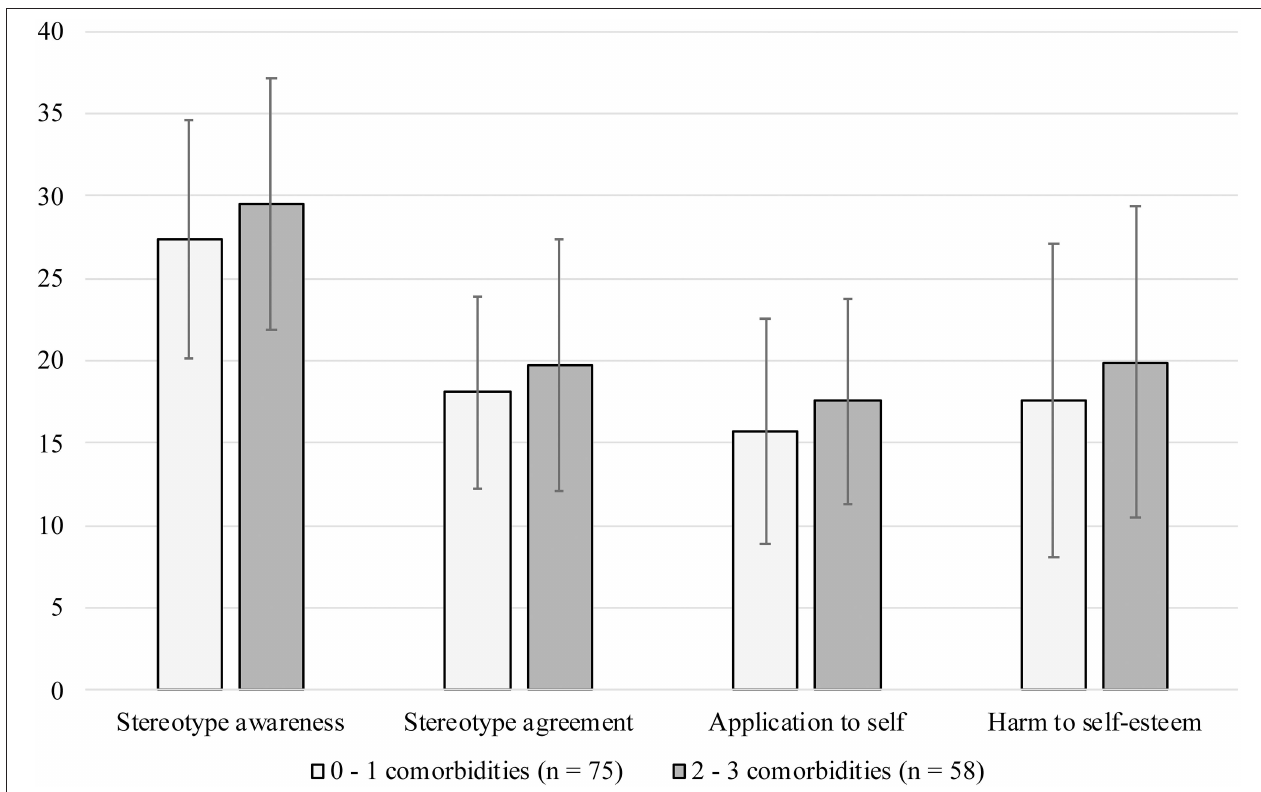
FIGURE 2 | Mental health self-stigma scores (means and standard deviations) according to number of